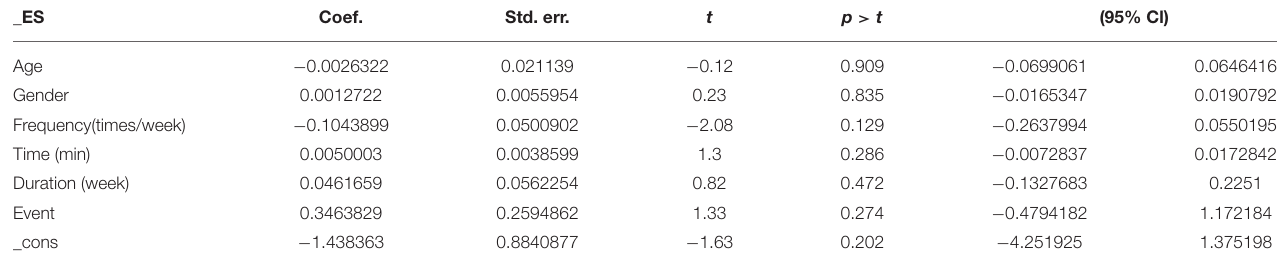
TABLE 5 | Covariate regression analysis of depression in patients with